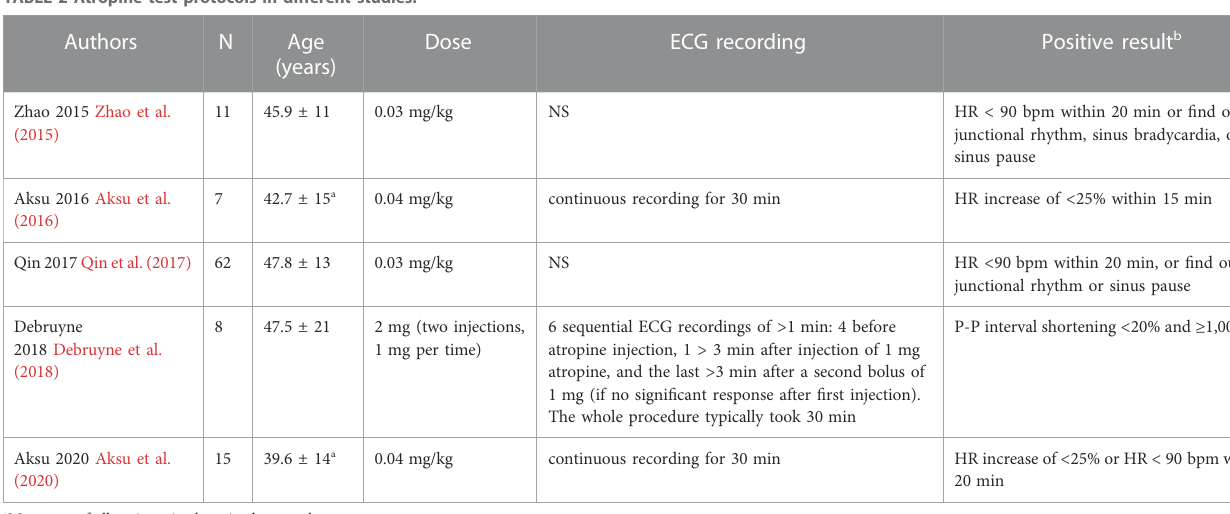
TABLE 2 Atropine test protocols in different